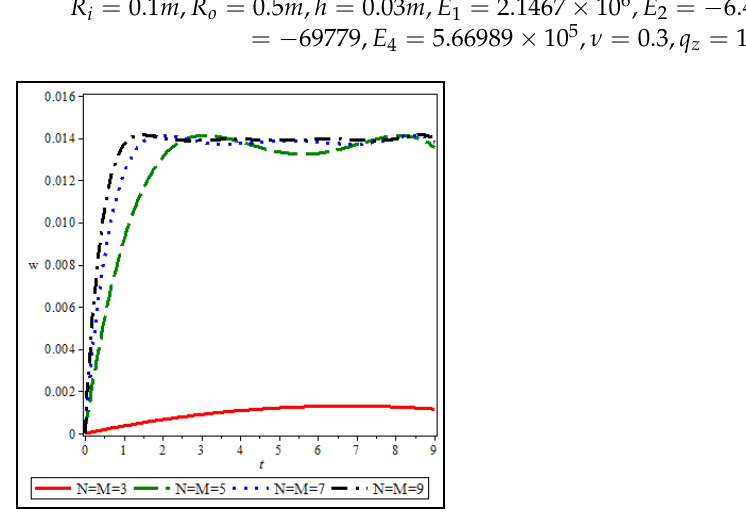
Figure 3. Investigation of the result’s